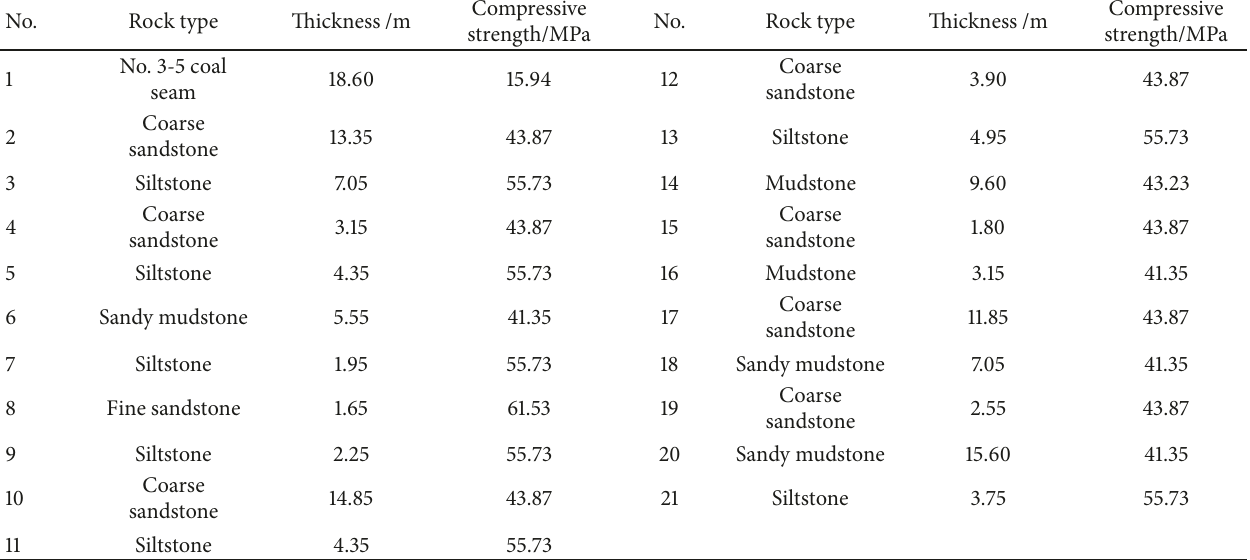
Table 10: Geological data of all the strata overlying above the working face.